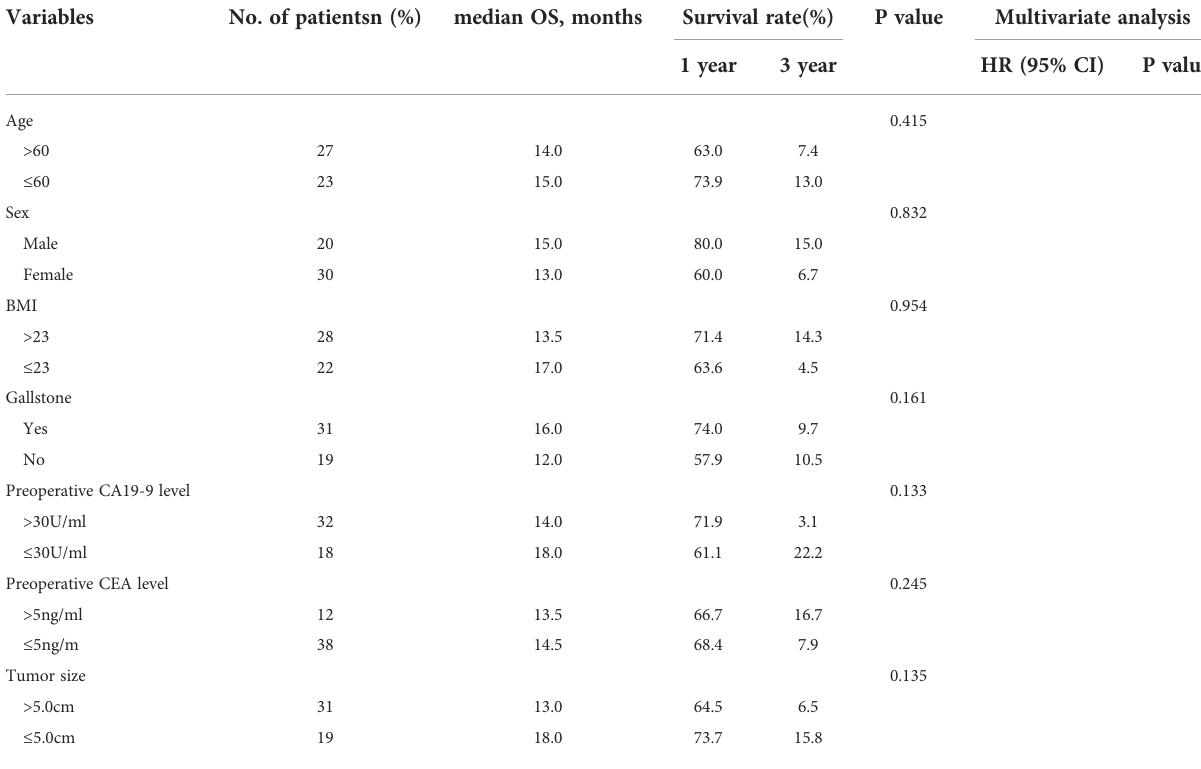
TABLE 3 Univariate and multivariate analysis of OS for patients with